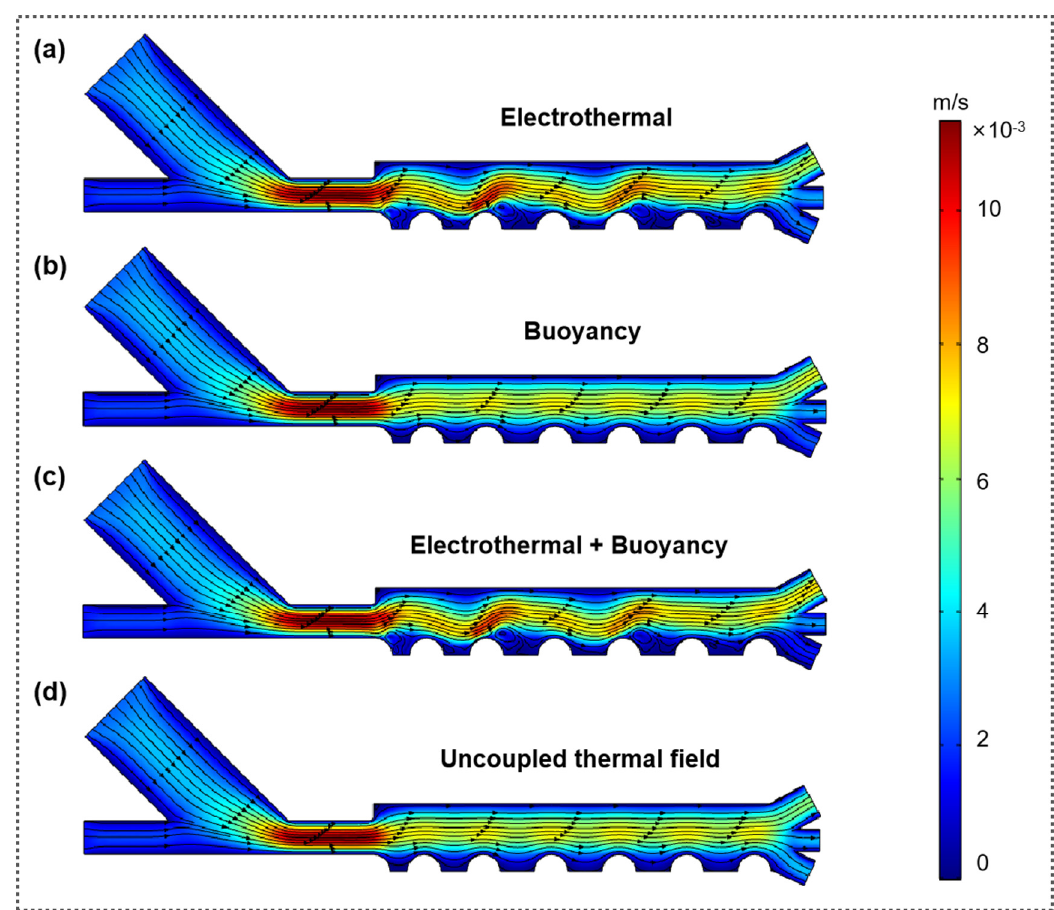
Figure A7. Comparison of the flow stream profile in continuous flow systems: ( a ) only electrothermal flow; ( b ) only buoyancy flow; ( c ) combined electrothermal and buoyancy flows; ( d ) uncoupled thermal field.